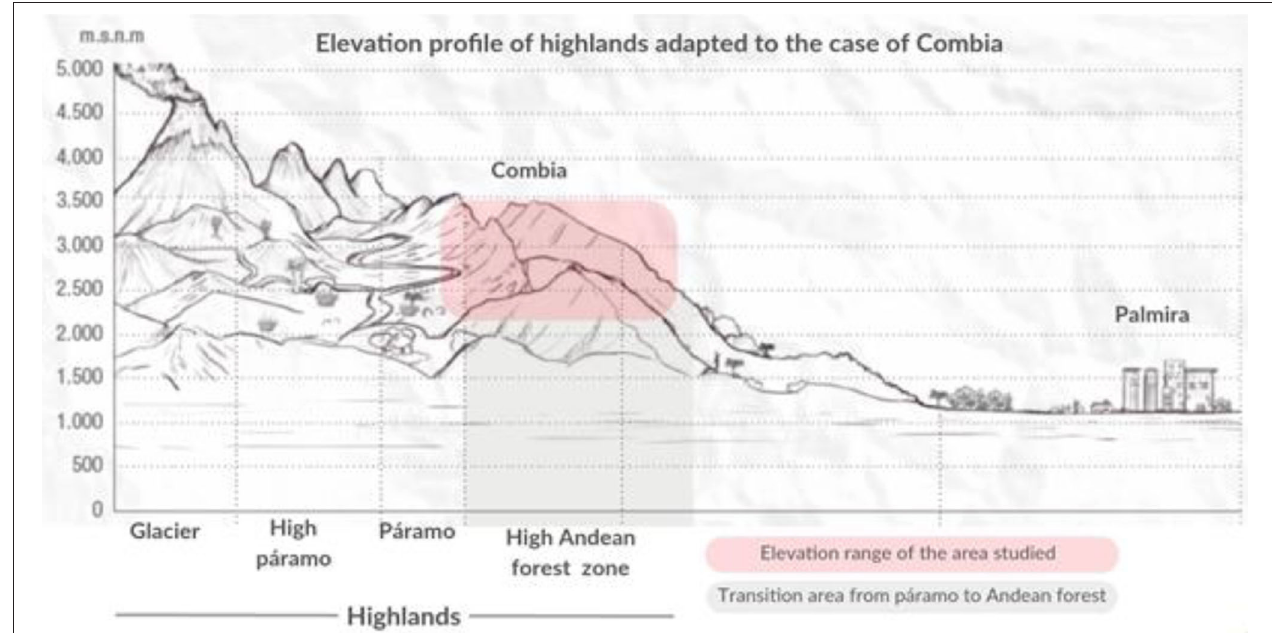
FIGURE 3 | Elevation profile of the highlands in the Las Hermosas region. Adapted and modified from Osejo et al.